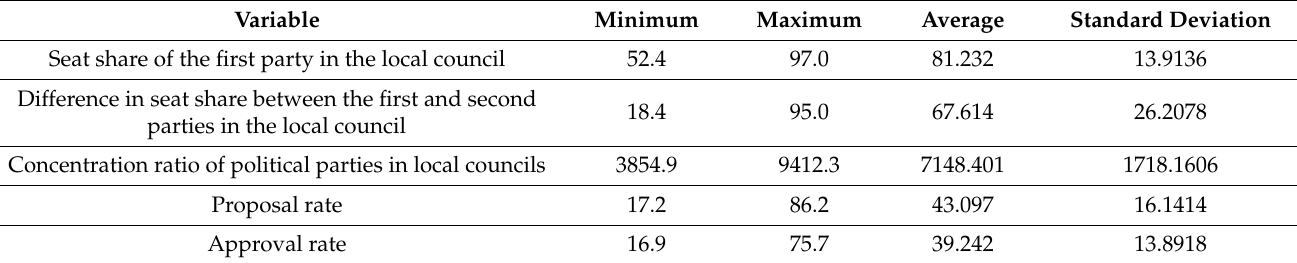
Table 3. Basic data for analysis.